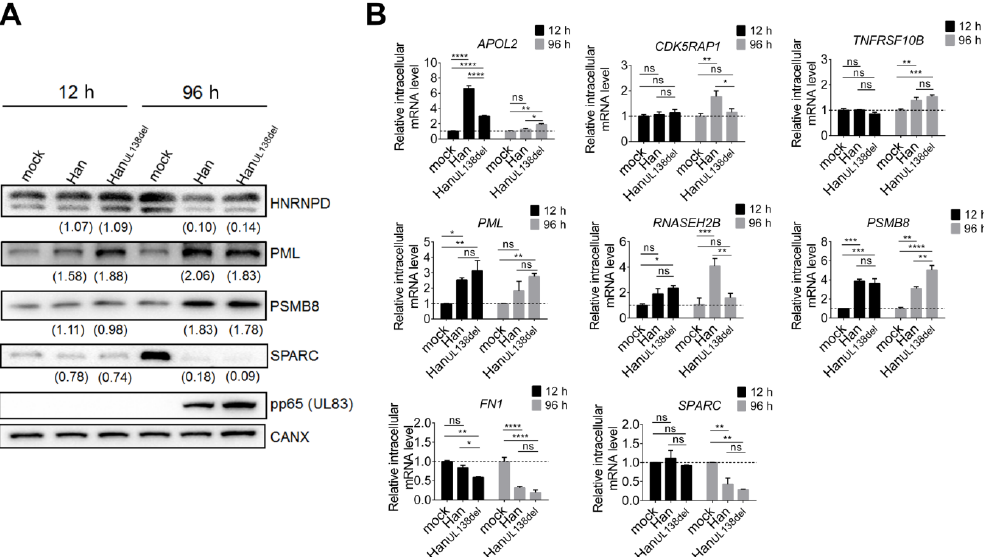
Figure 2. Validation of MS results. ( A ) Western blot analysis of MRC5 cells infected with Han